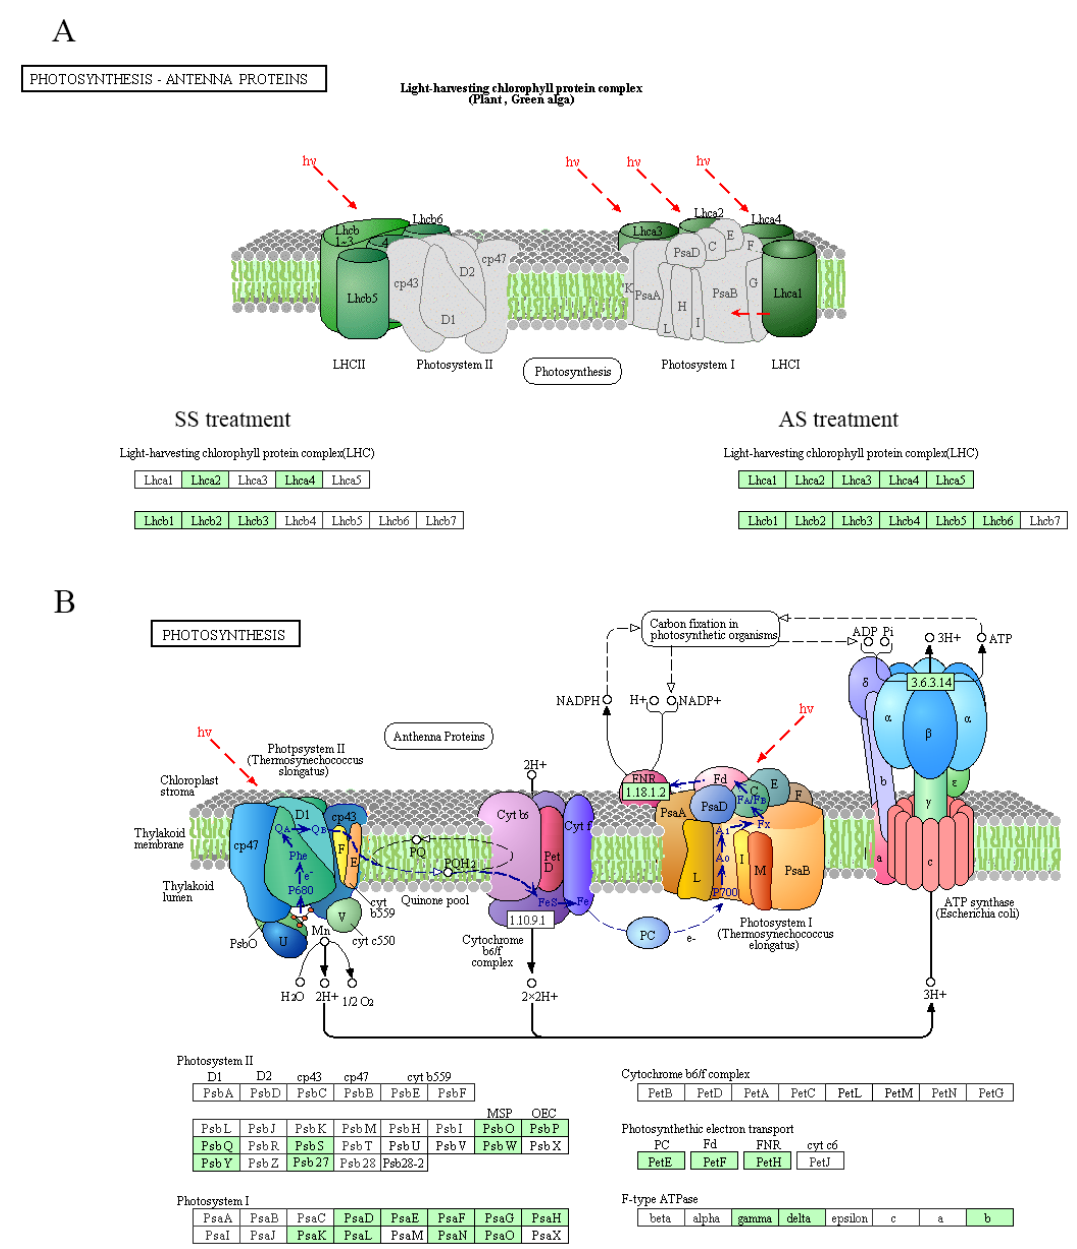
Figure 6. Summary of gene expression related to the photosynthetic machinery in response to SS and AS. KEGG maps of the “photosynthesis-antenna proteins” ( A ) and “photosynthesis” ( B ) pathways are displayed. The green boxes indicate expression levels of the corresponding genes that were downregulated.